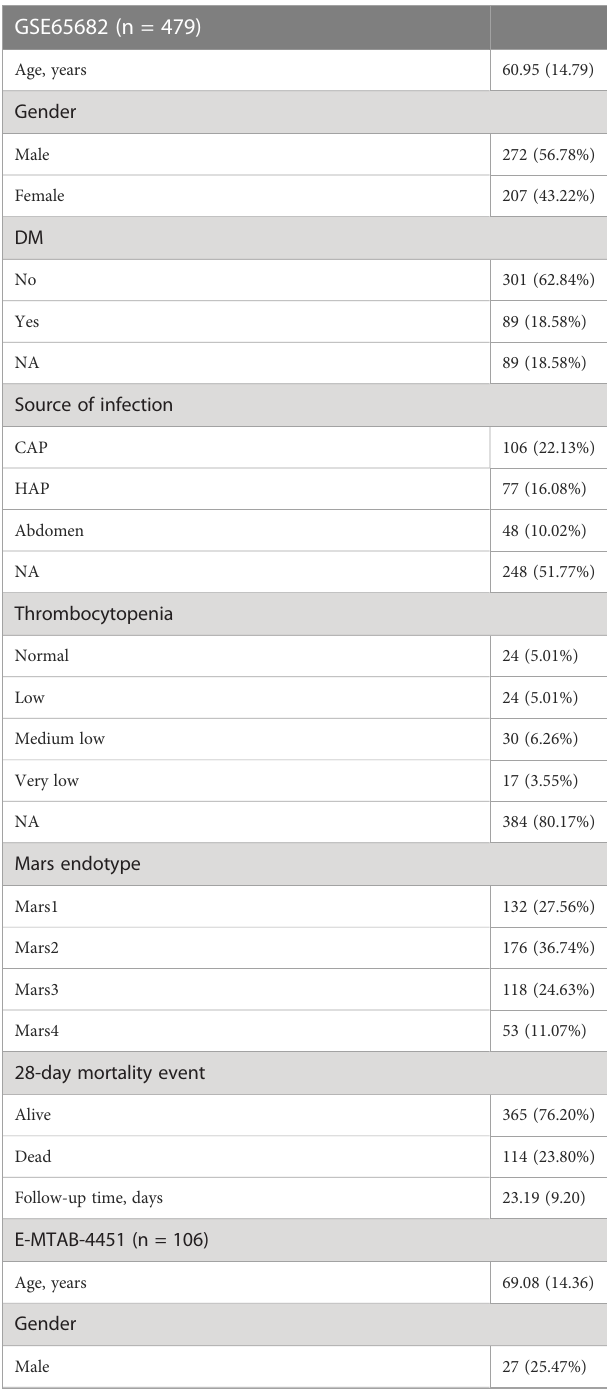
TABLE 1 Baseline characteristics of sepsis patients included in this